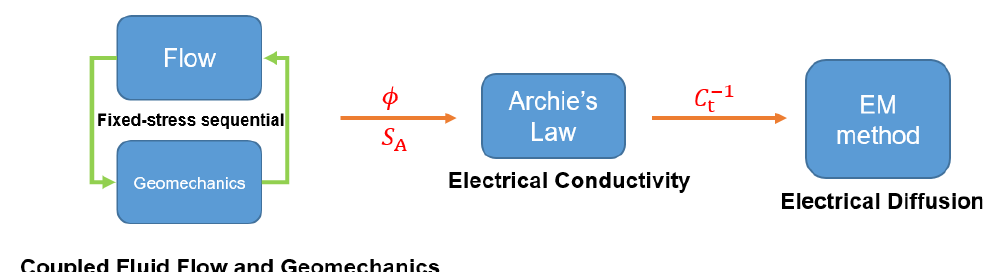
Figure 1. Flow chart for the integrated coupled flow-geomechanics-EM geophysics